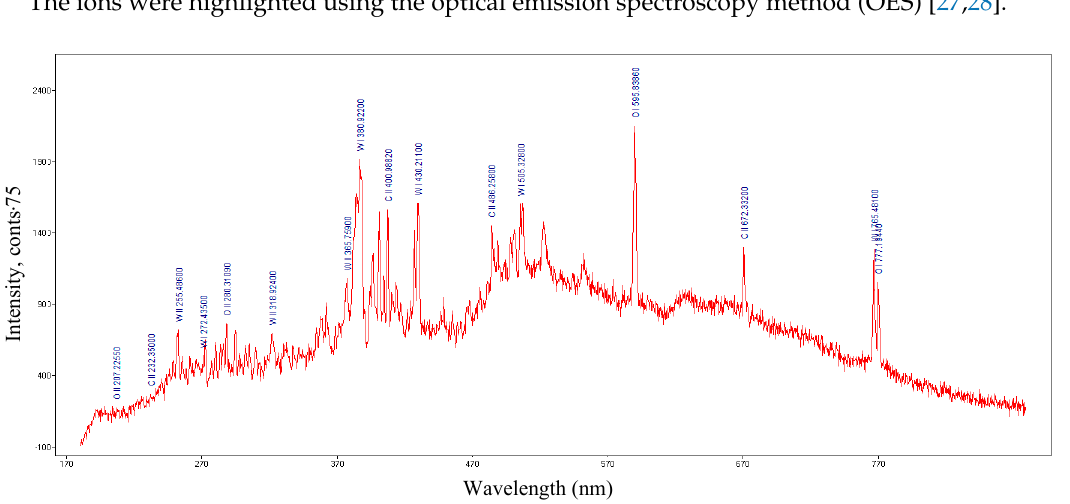
Figure 4. Optical emission spectra of the plasma: Ions generated during CO 2 dissociation process.